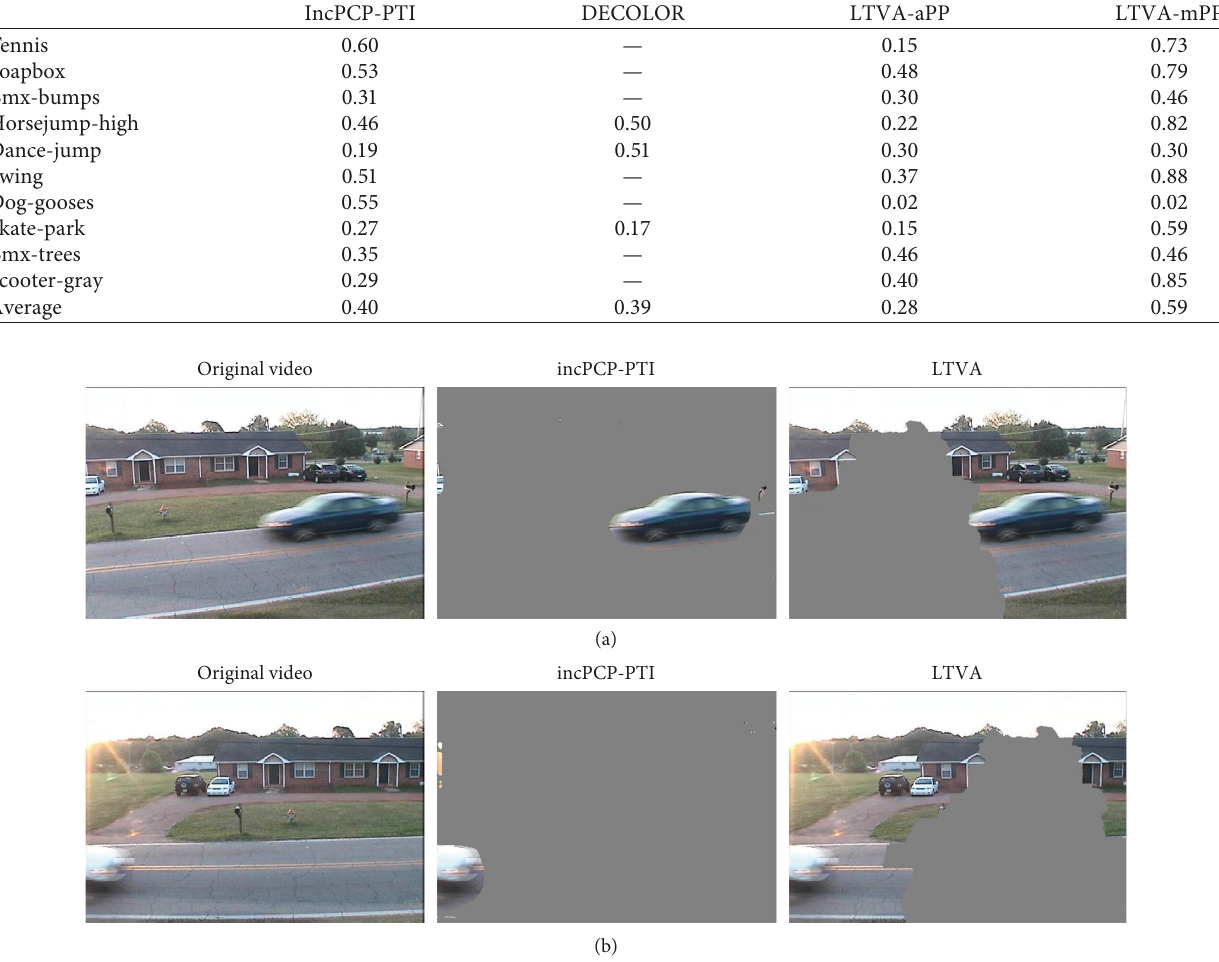
Figure 8: Frames 988 (a) and 1008 (b) of the video and the segmented sparse components for the CP video obtained with both incPCP-PTI and LTVA. It is observed that LTVA is unable to separate the moving objects any of the frames. This figure is a modified version of Figure 6 in